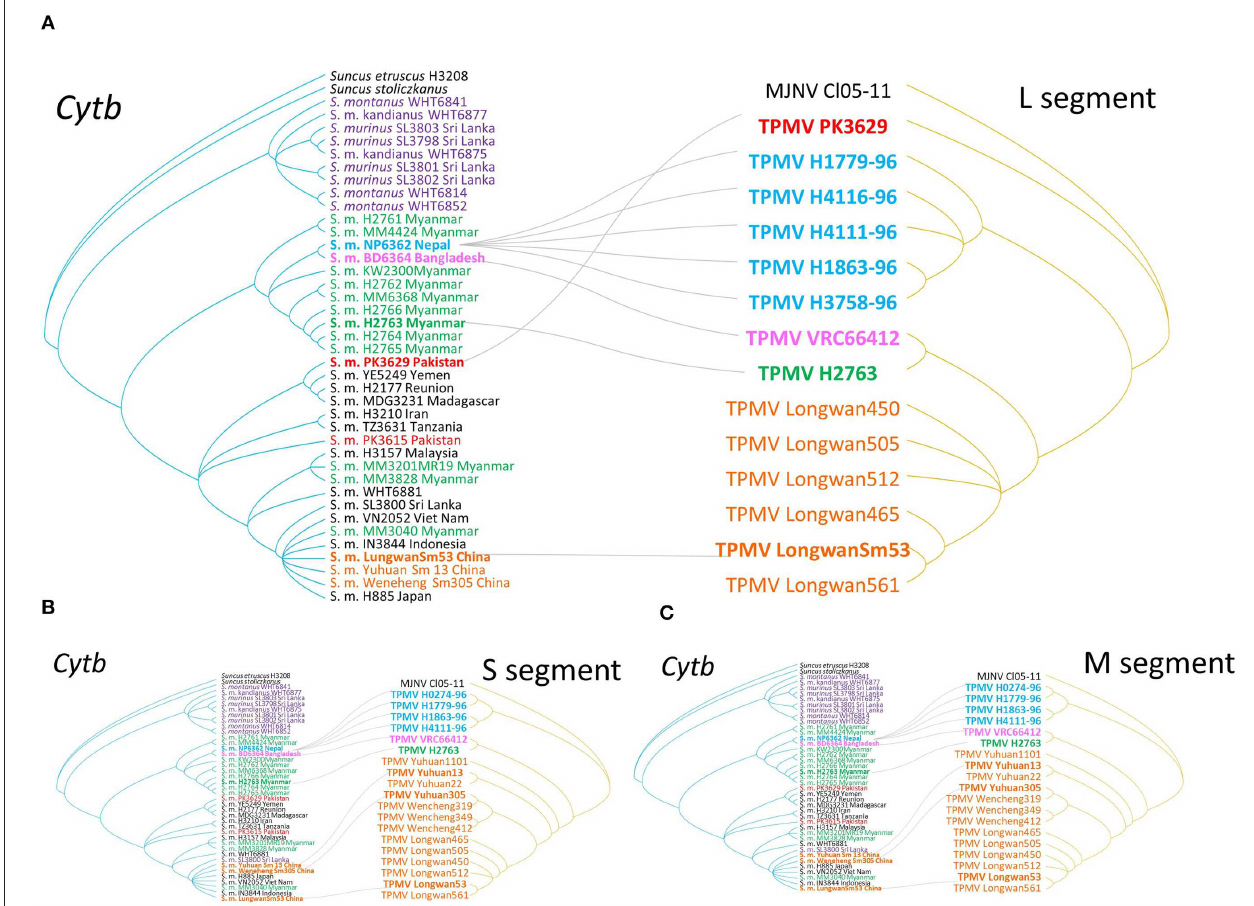
FIGURE 3 | Comparisons of phylogenies of TPMV and their host species Asian house shrew. The host trees on the left were based on cytochrome b (cyt b ) gene, while the hantavirus tree on the right was based on the nucleotide sequences of L- (A) , S- (B) , and M-segments (C) , respectively. Letterings for taxa are shown in purple for Sri Lanka, green for Myanmar, blue for Nepal, pink for Bangladesh and India, red for Pakistan, orange for China, black for the other countries, and out groups in both trees. Nepal Asian house shrew was adapted experimental animal strain NP6362. Bangladesh experimental strain BD6364 was used for alternative Indian strain.